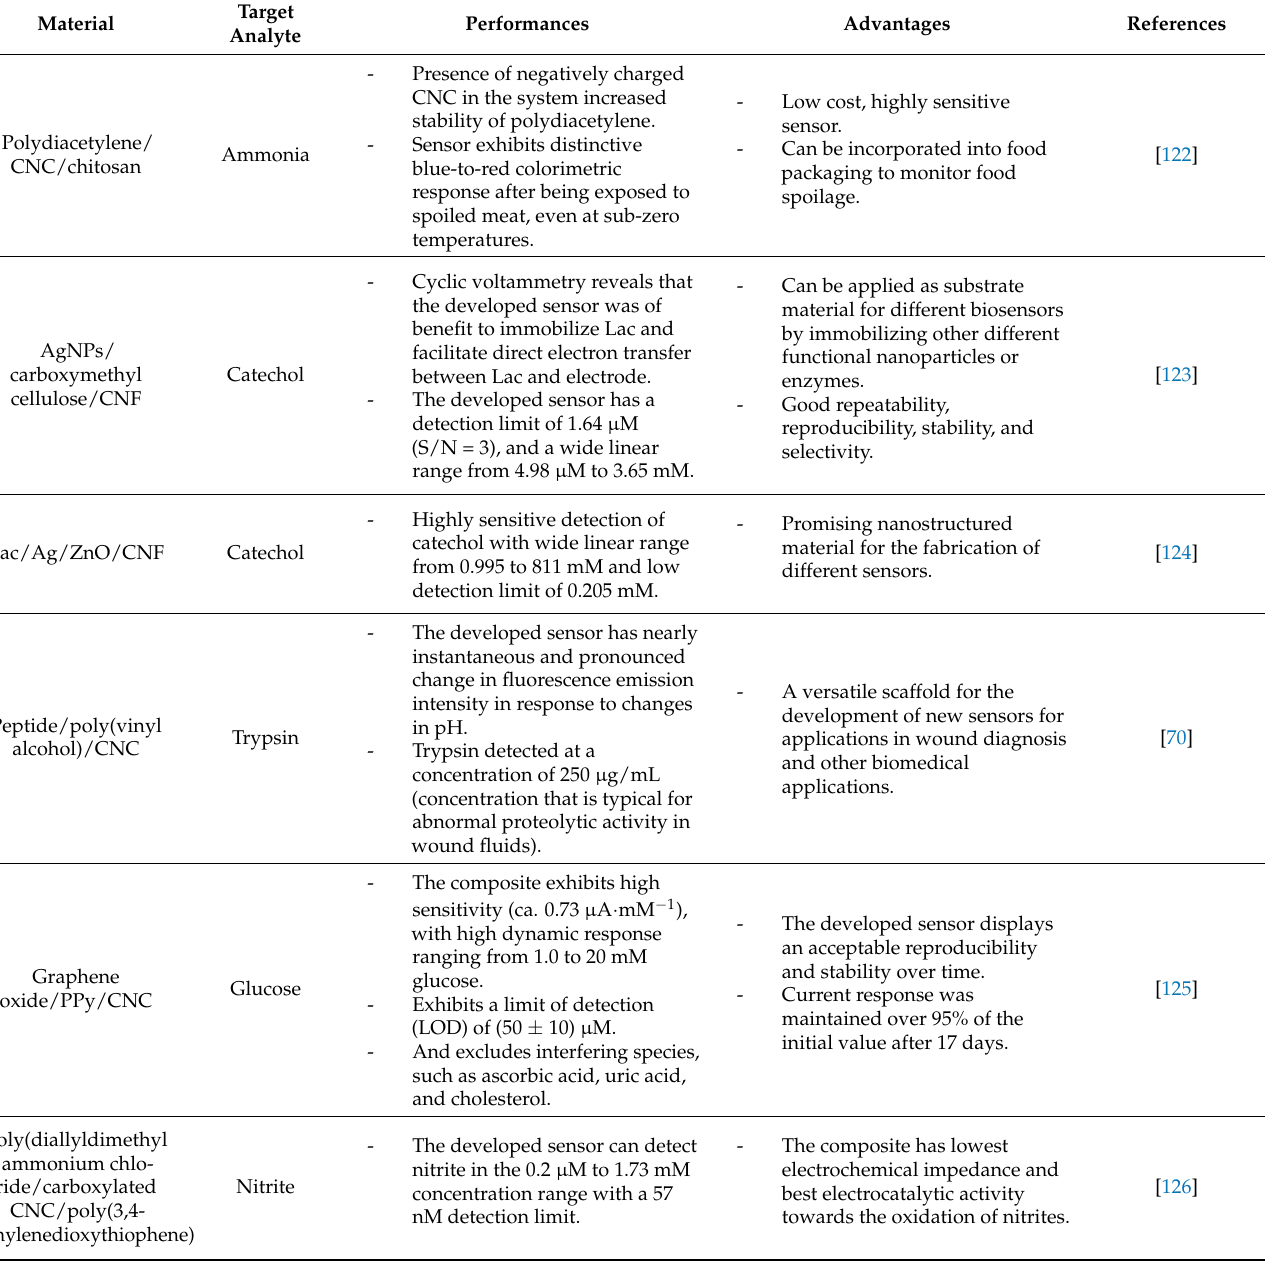
Table 5. Performance of nanocellulose hybrid composites chemical